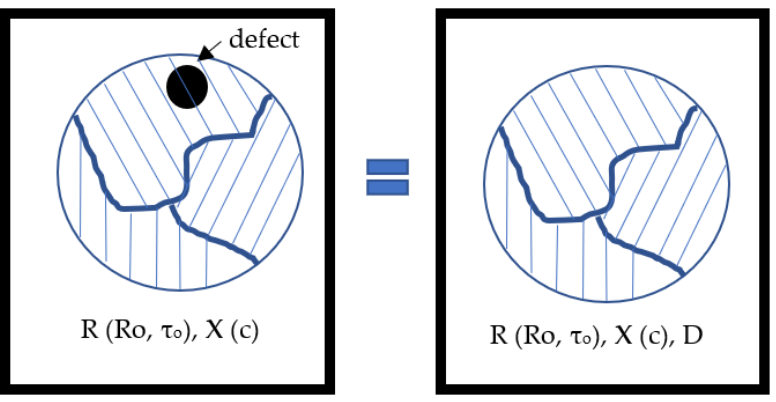
Figure 1. Simplified diagram of features model.